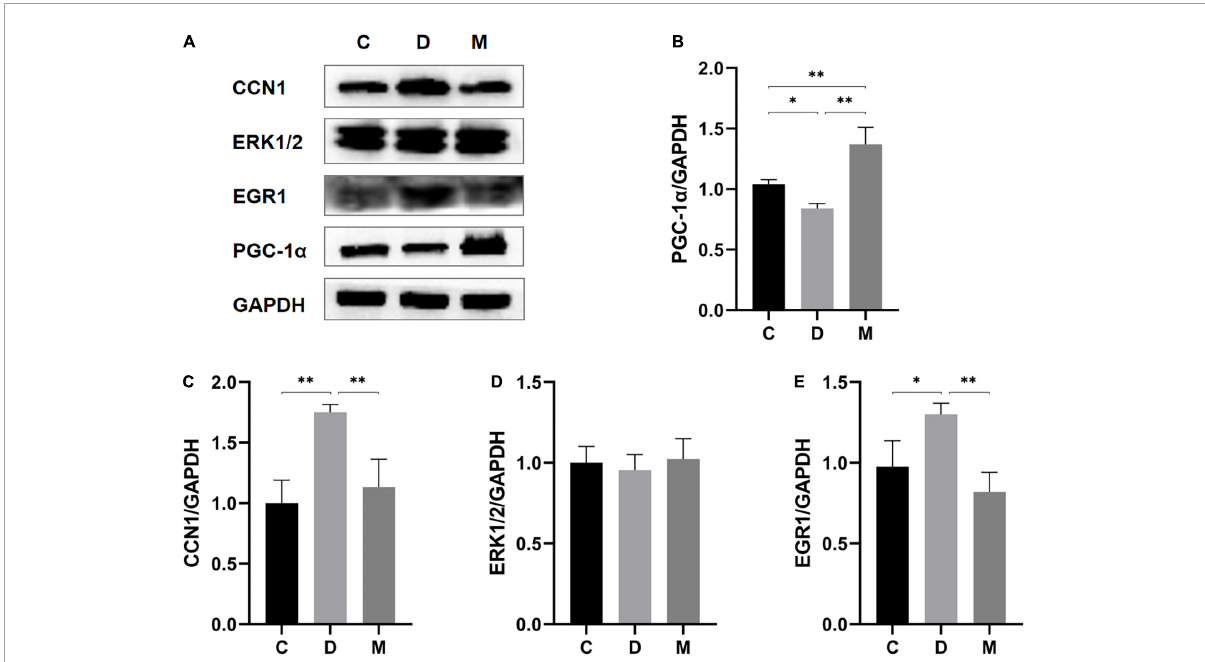
FIGURE7 Protein expression levels of PGC-1 α , CCN1, ERK1/2, and EGR1 in ventricular cardiomyocytes from rats in C, D, and M groups. (A–E) Western blot analysis of PGC-1 α , CCN1, ERK1/2, and EGR1. Data are expressed as mean ± SD; ∗ p < 0.05, ∗∗ p < 0.01; C, non-diabetic control group; D, diabetic control group; M, diabetic MOTS-c injection group.